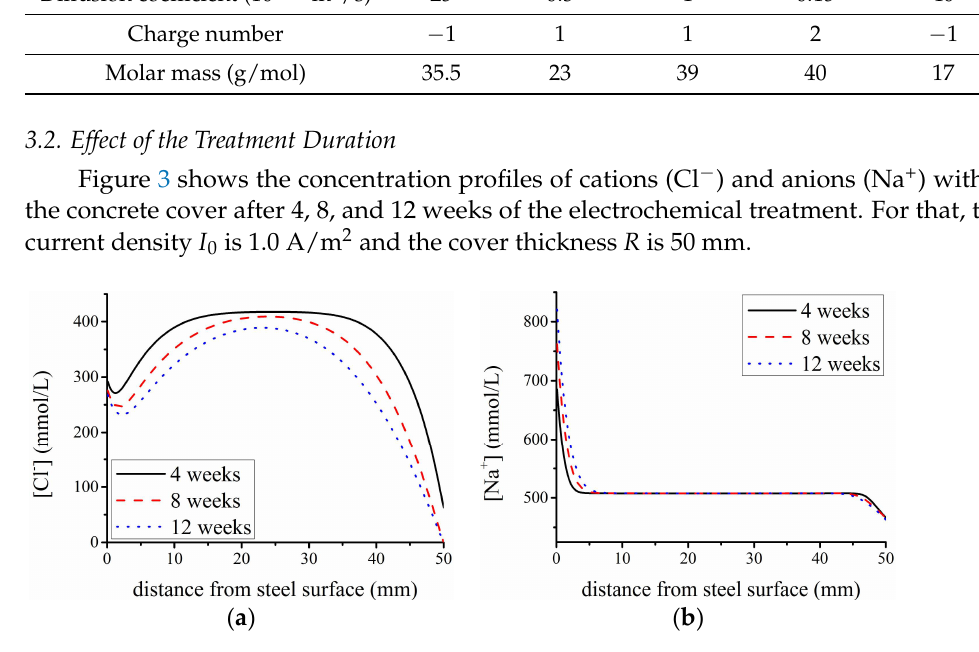
Table 1. Parameters for the multiple ionic transport model.